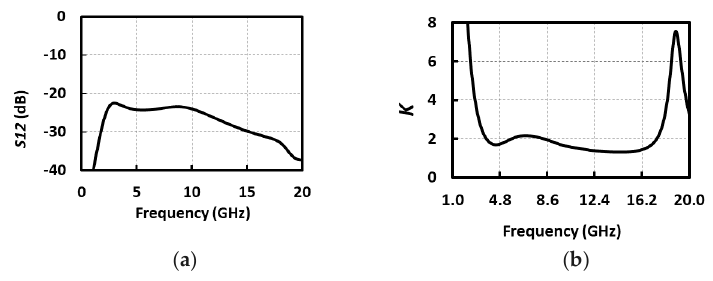
Figure 4. Stability simulations: ( a ) S 12 and ( b ) K factor.